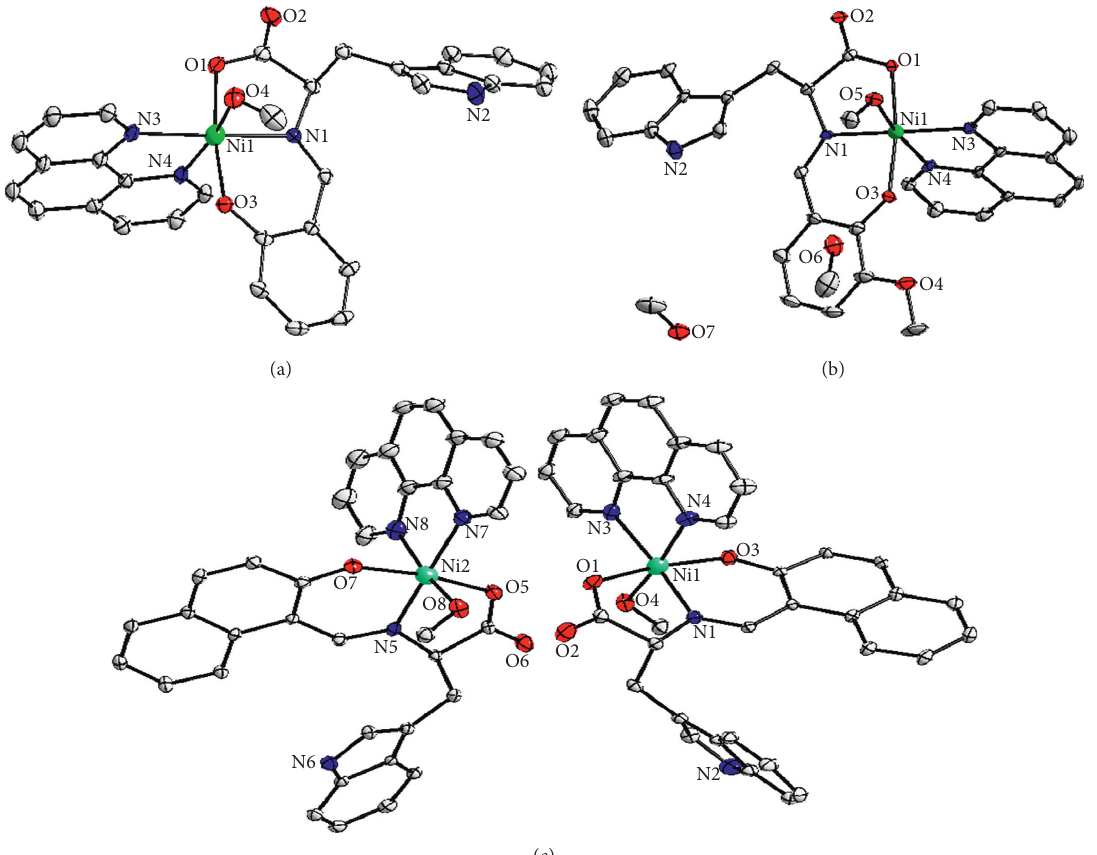
Figure 1: Molecular structures of complexes 1 (a), 2 (b), and 3 (c) with some atoms labeled. Hydrogen atoms on the ligands are omitted for